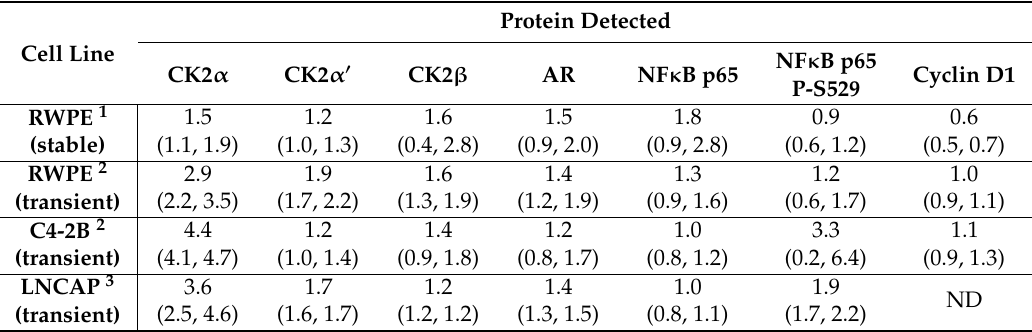
Table 1. Fold-change in protein level due to increased expression of ck2 α .